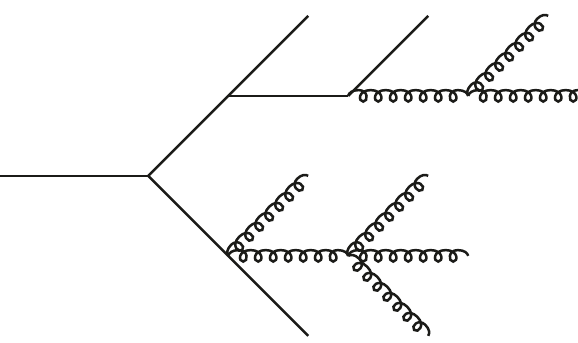
Figure 1 . A typical Feynman diagram that might appear in GBAS theory, where the solid and curly lines depict biadjoint scalars and gauge fields, respectively. This has a dual interpretation in YM theory, where the solid and curly lines depict field strengths and gauge fields, respectively. The root leg is depicted on the left, with all leaf legs to the